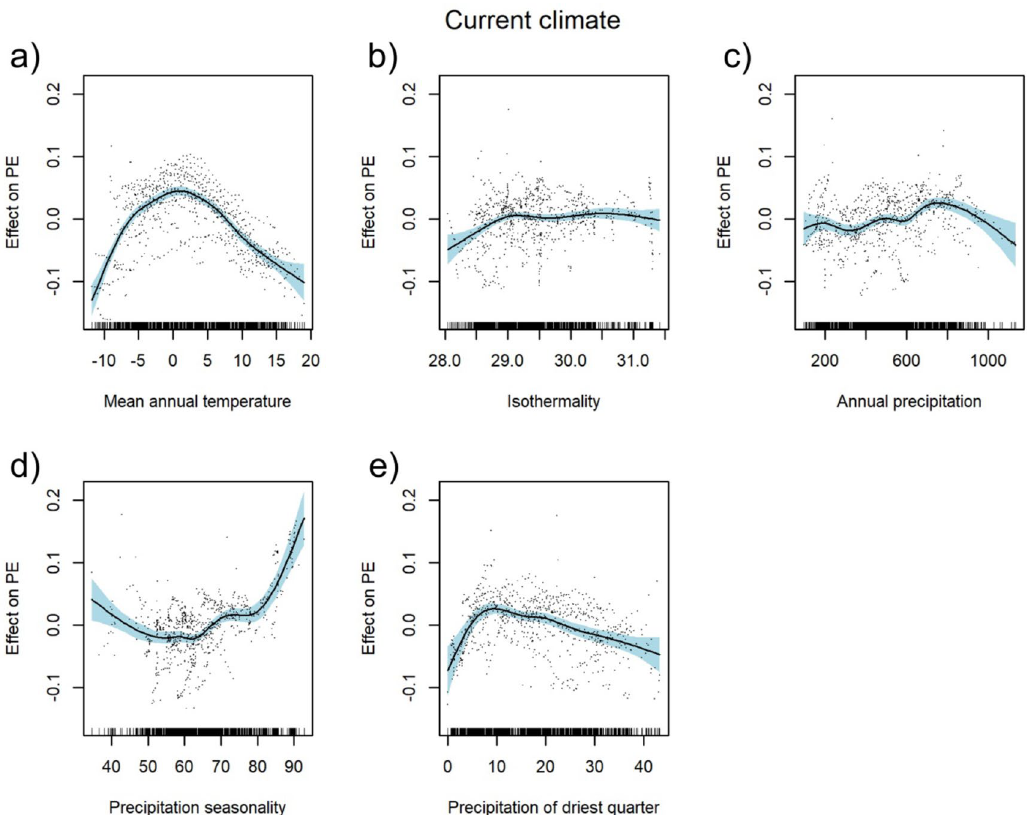
Figure 2. Partial response curves of current climate predictors with smooth effects in the generalised additive model (GAM). Effect of annual mean temperature [°C] ( a ), isothermality [%] ( b ), sum of annual precipitation [mm] ( c ), precipitation seasonality [%] ( d ), and precipitation of the driest quarter [mm] ( e ); PE: proportion of endemic plant species to overall plant species richness as target variable. For model summary of the GAM